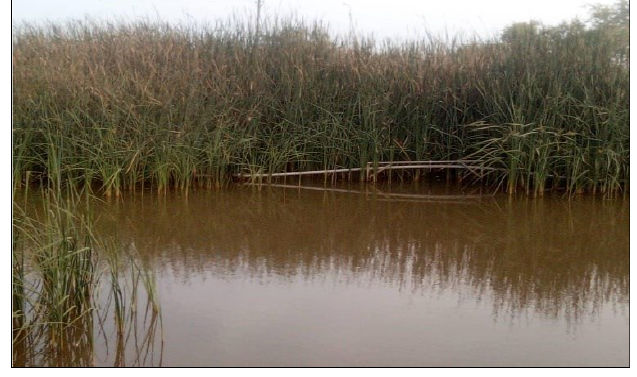
Fig. 8. Typha australis along the Senegal River